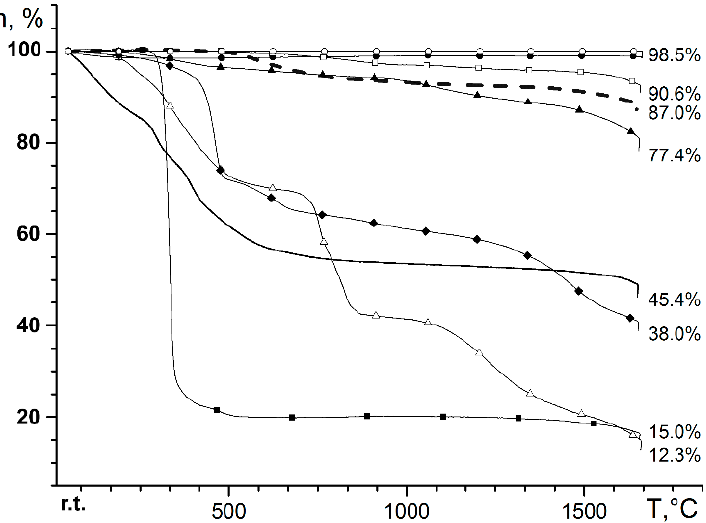
Figure 3. Weight loss in the selected samples according to TGA (m, %) and applied temperature program; notations of carbon materials: nanoglobular carbon and nanotubes, 98.5%; coke, 90.6%; CE2, 87%; carbon fiber, 77.4%; CE1, 45.4%; MSW, 38%; microcrystalline cellulose, 15%; humins,